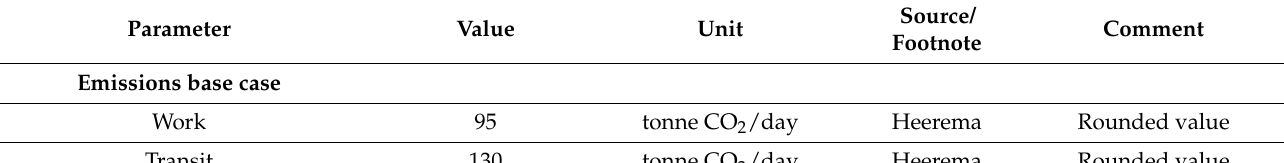
Table A2. Emissions related assumptions and calculated